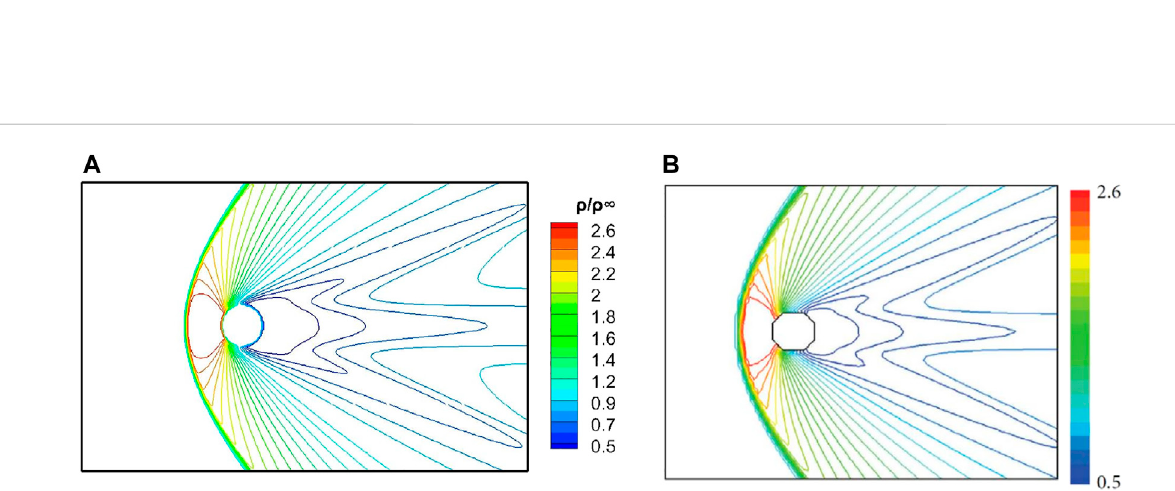
FIGURE 21 Density contour plot using the present IBM (A) and the IBM of Takahashi et al. (2014) (B)